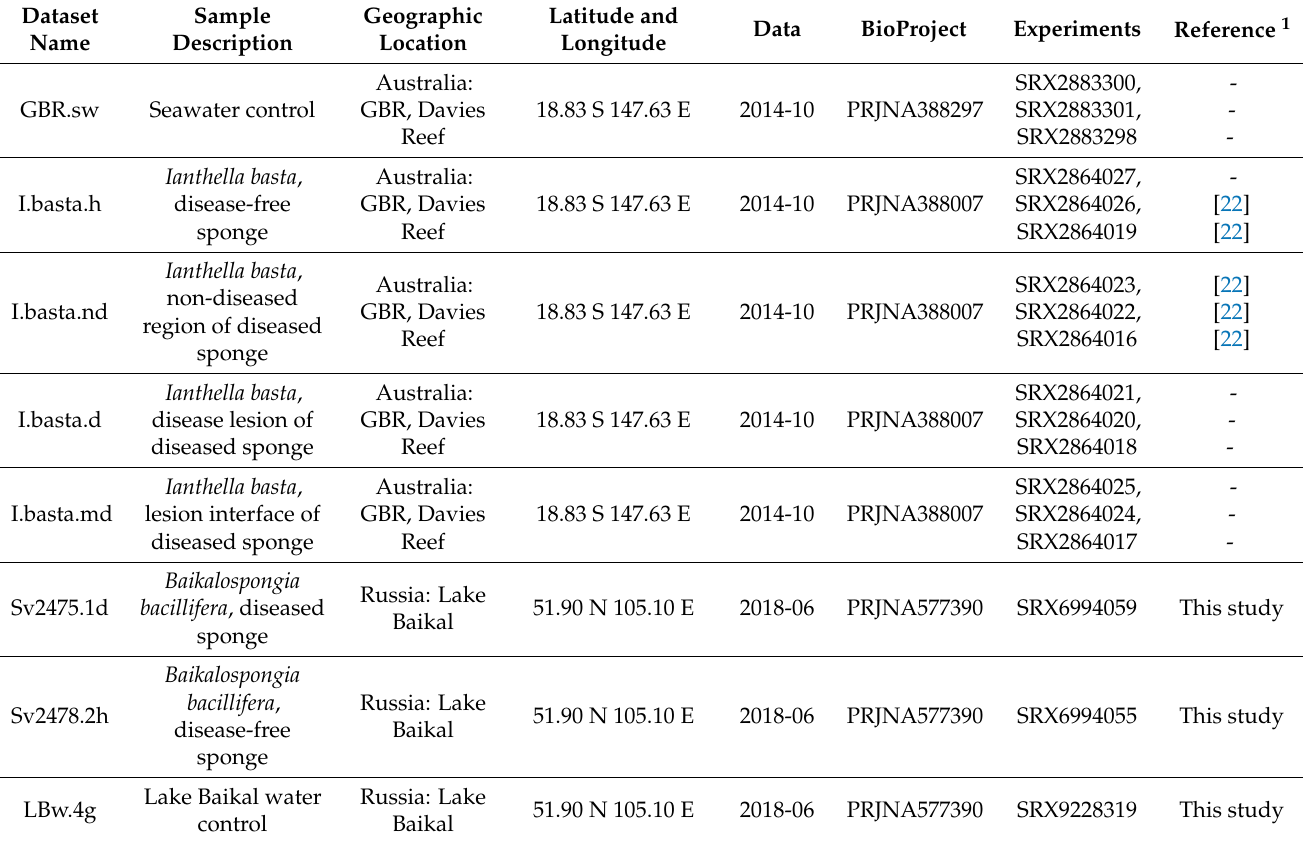
Table 1. Description of virome datasets used for